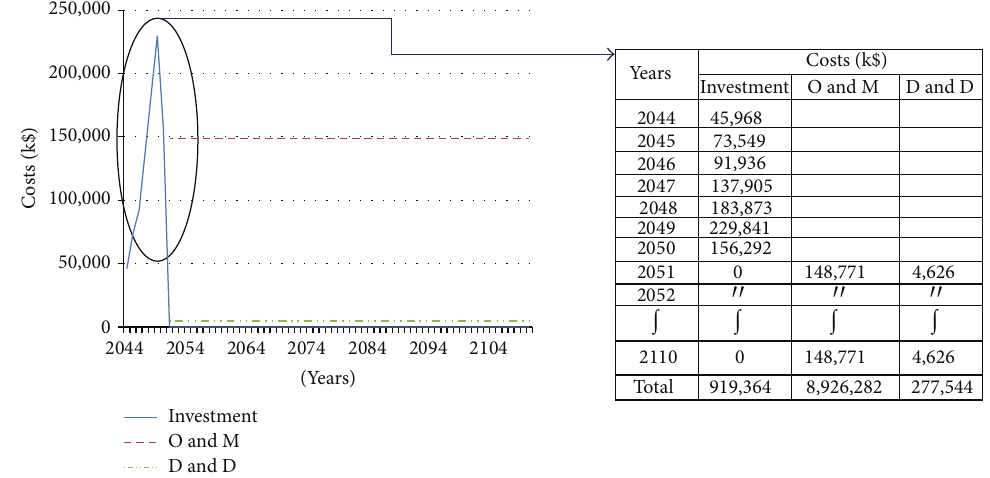
Figure 6: Cost trends of SFR